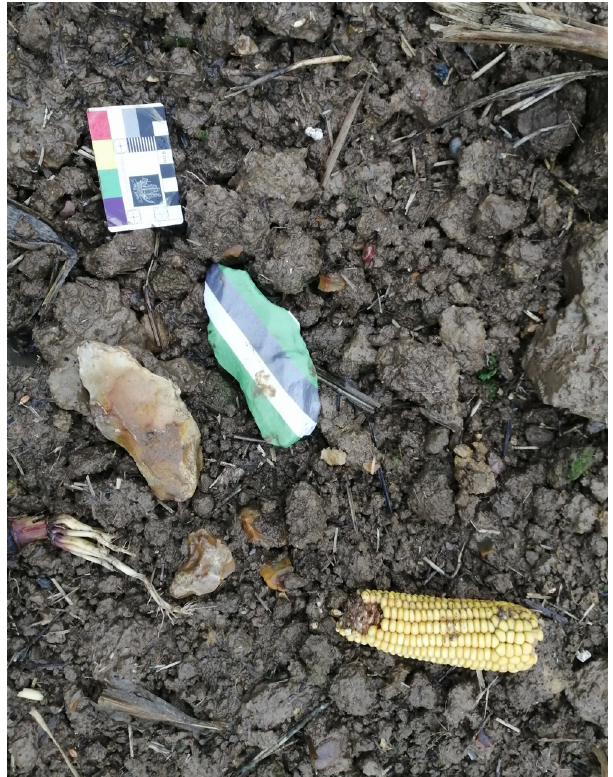
Figure 19: The cycle of silica and corn